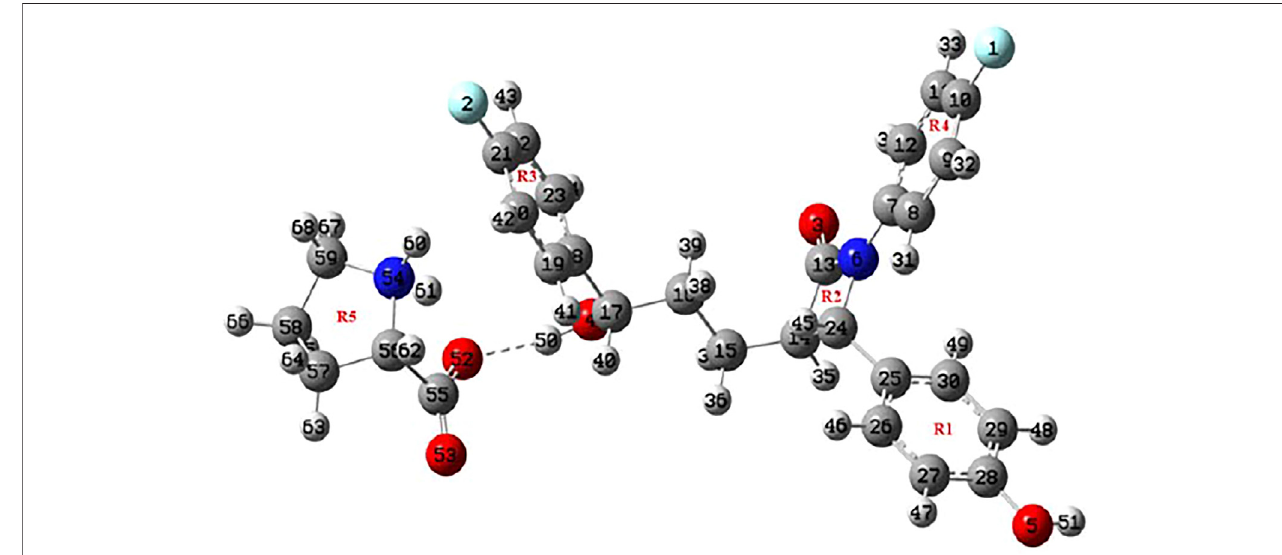
FIGURE 1 | Optimized structure of EZT +